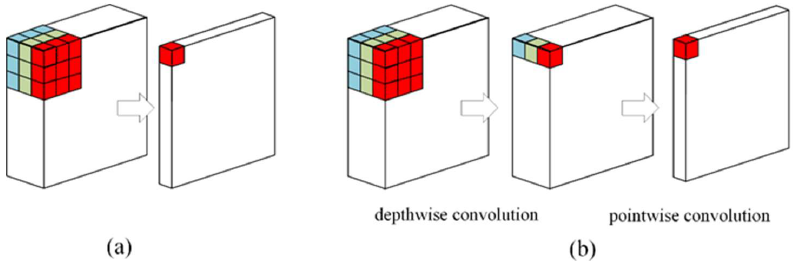
Figure 5. Representation of the comparison between ( a ) conventional convolutional neural networks (CNNs) and ( b ) depthwise separable CNN.